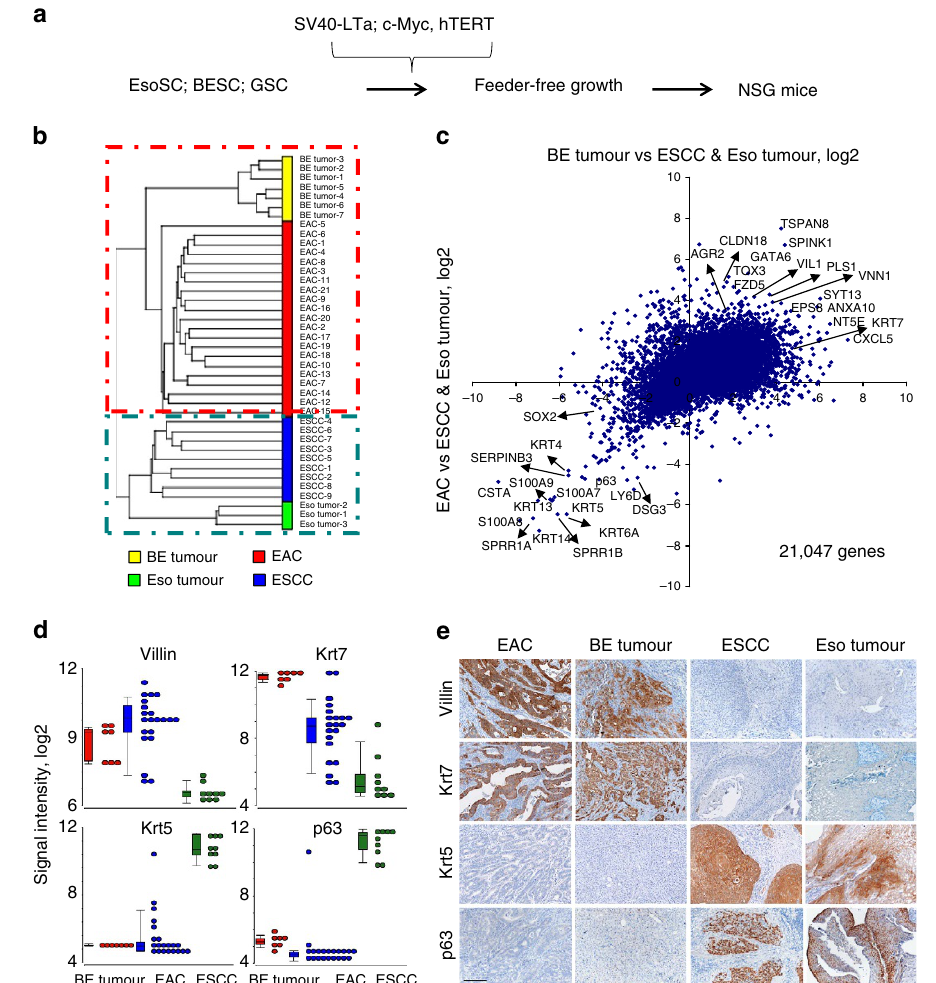
Figure 4 | Tumours derived from transformed BESC and EsoSC pedigrees. ( a ) Schematic of stem cell transformation and xenografting in immunodeficient mice. ( b ) Dendritic relationship of gene expression profiles of EACs, ESCC and tumours developed in immunodeficient xenografted transformed Barrett’s (BE tumour; n ¼ 7) and oesophageal (Eso tumour; n ¼ 3) stem cell pedigrees. ( c ) Correlation cluster analysis of genes expressed in BESC-derived tumours and those expressed in EAC. ( d ) Box plot of gene expression intensity from arrays for four genes marking tumours arising from xenografted transformed BESCs and EAC and squamous cell carcinomas. The top whisker shows maximum, the boxed zone shows 1st quartile, mediam and 3rd quartile, while the lower whisker shows minimum with outliers indicated (see Methods section). ( e ) Immunohistochemistry on sections of EAC, tumours derived from transformed BESC pedigrees (BE tumour), ESCC and tumours from transformed oesophageal stem cell pedigrees (Eso tumour). Scale bar,